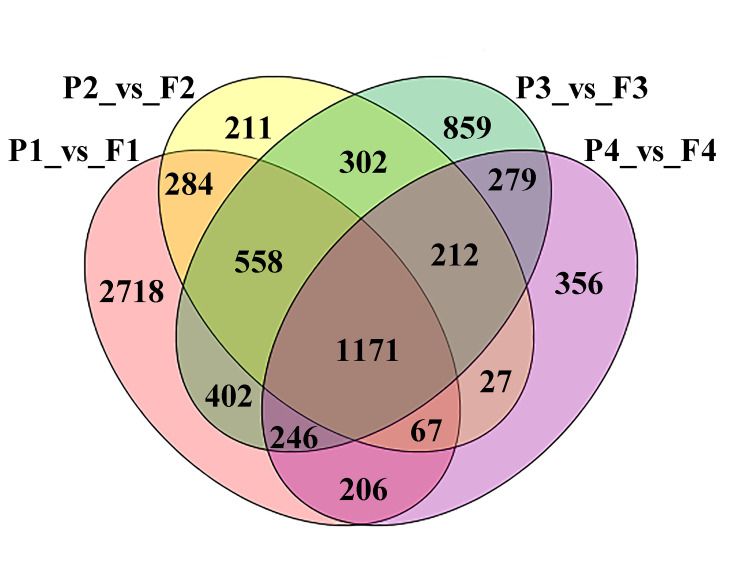
Differentially expressed genes (DEGs) detected between different comparisons in loquat.P and F represent peel and flesh, while 1,2,3 and 4 indicate four development stages, i.e. S1, S2, S3 and S4.